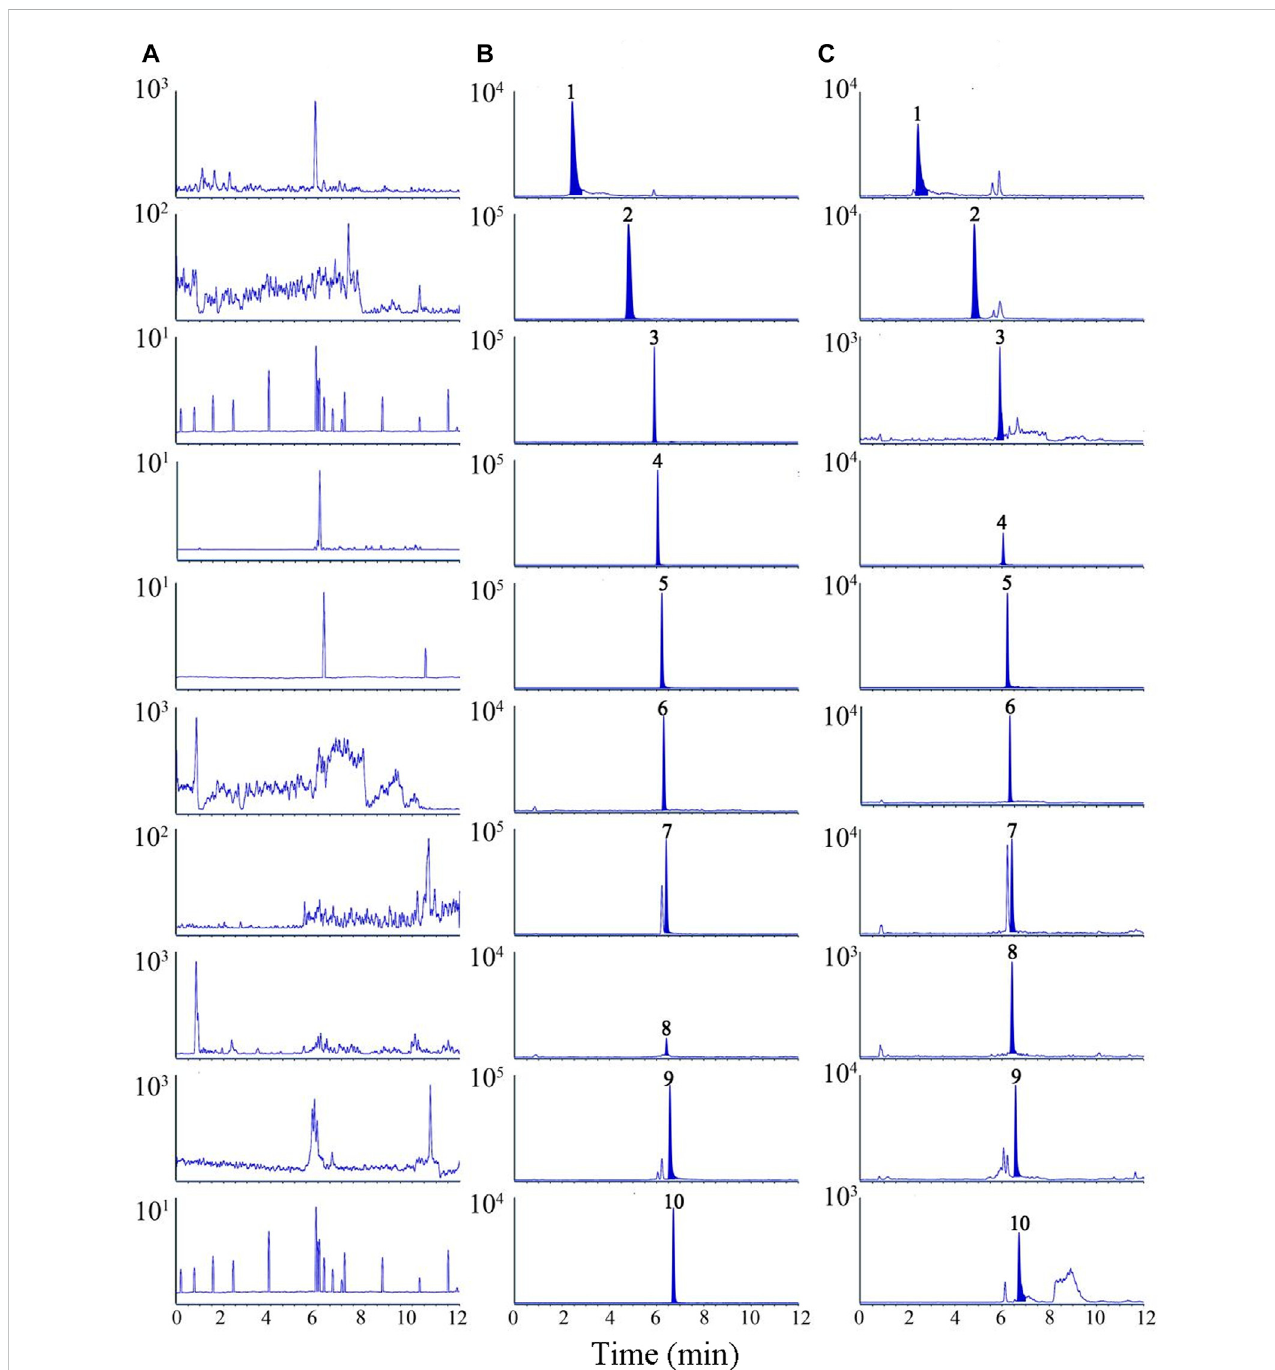
Representative multiple reaction monitoring (MRM) chromatograms of nine analytes and IS in rat plasma samples. (A) blank plasma sample, (B) blank plasma spiked with nine analytes and IS, (C) plasma samples after oral administration of TC extracts. 1. chebulic acid, 2. gallic acid, 3. protocatechuic acid, 4. corilagin, 5. chebulagic acid, 6. caffeic acid (IS), 7. chebulinic acid, 8.1,2,3,4,6-O-pentagalloylglucose, 9. ellagic acid, 10. ethyl